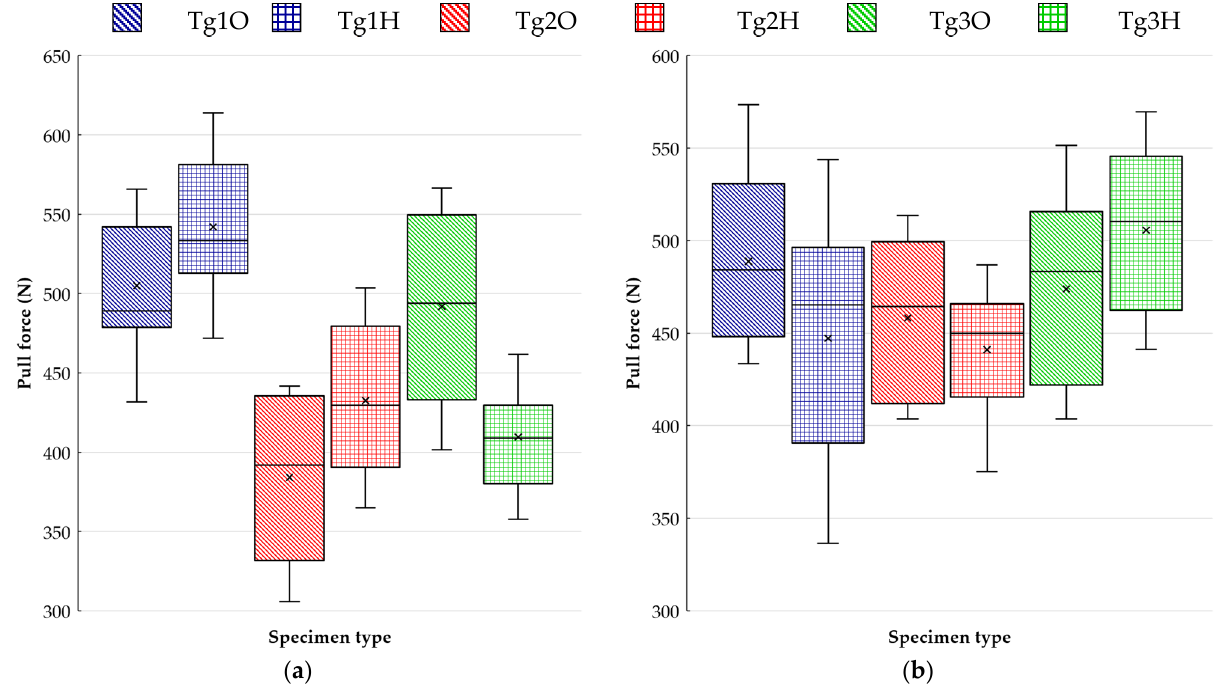
Figure 9. Explanation of the sample marking.